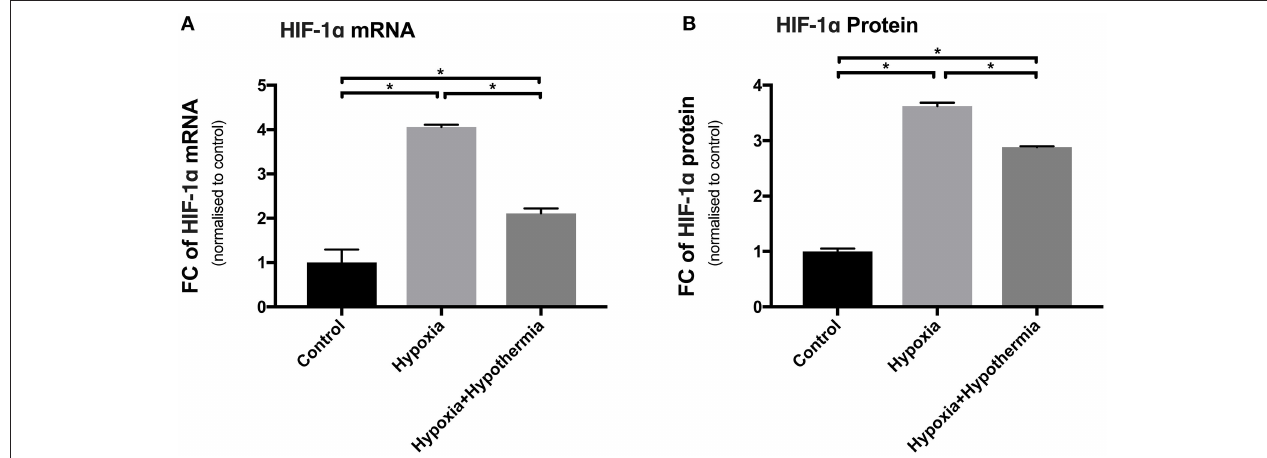
FIGURE 1 | HIF-1 α mRNA and protein expression levels in cultured primary human astrocytes following hypoxia or hypoxia + hypothermia. Data shown include mean fold change in expression ( ± S.E.M.) of cells treated with 5% oxygen for 6h with no temperature change (Hypoxia) or with 32 ◦ C hypothermic intervention after initial incubation for 2h of hypoxia for a total of 6h (Hypoxia + Hypothermia) compared with untreated normoxic, normothermic astrocytes (Control). Each bar represents the Mean ± S.E.M. for each of the conditions. Kruskall-Wallis with Conover-Inman post-hoc analysis tests were used to identify significant differences between samples using StatDirect 3 software. *Represents statistical significance ( p < 0.001). (A) Shows RT-qPCR data ( N = 5) using Taqman probes and 2 ∧ − 11 CT analysis normalized to the two housekeeping genes, PPIA and CDKN1B. (B) Shows Proteome Profiling Array data ( N = 3). FC, Fold change.